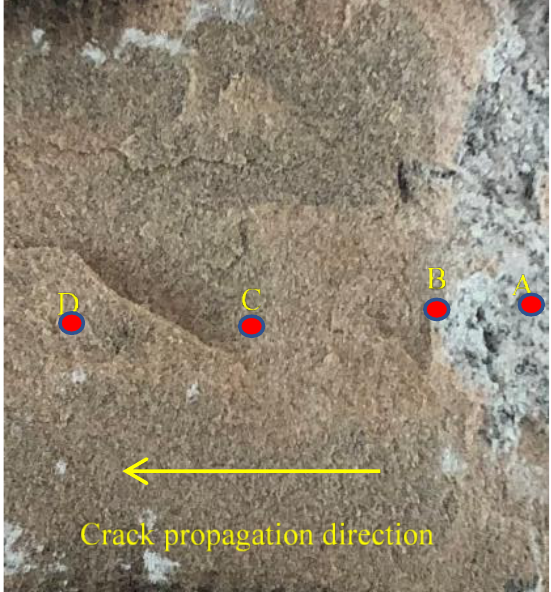
Figure 9. Positions for SEM analysis in sandstone after electric breakdown.